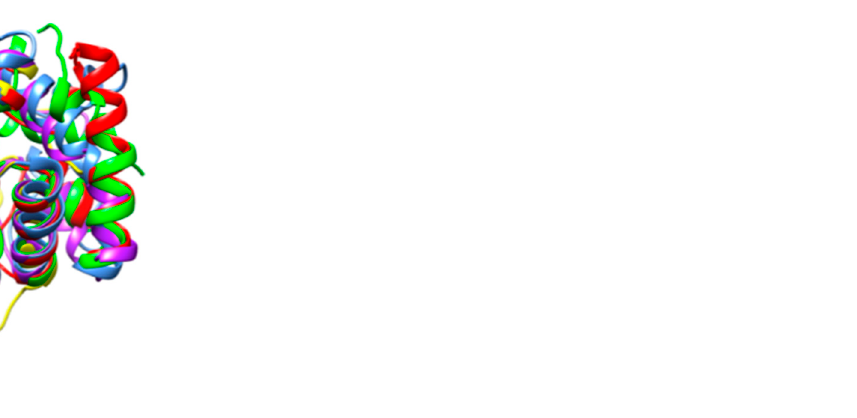
Figure 7. Superposition of the ribbon diagrams of hexamerin from Apis mellifera (red), Galleria mellonella (blue), Locusta migratoria (green), and Tenebrio molitor (purple). As previously reported, other less specific potential allergens such as apolipophorin III and larval cuticle protein, exhibit rather well conserved amino acid sequences but share a highly conserved three-dimensional structure. As an example, the multiple alignment